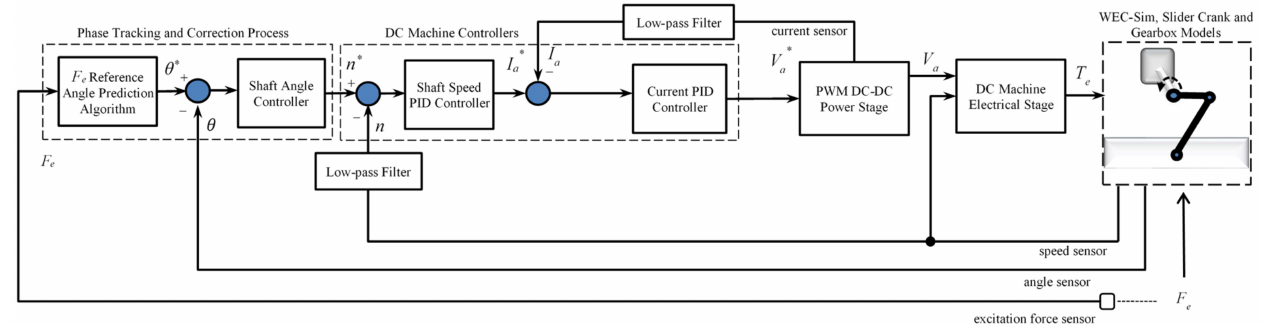
Figure 4. Overall control system block diagram for the numerical